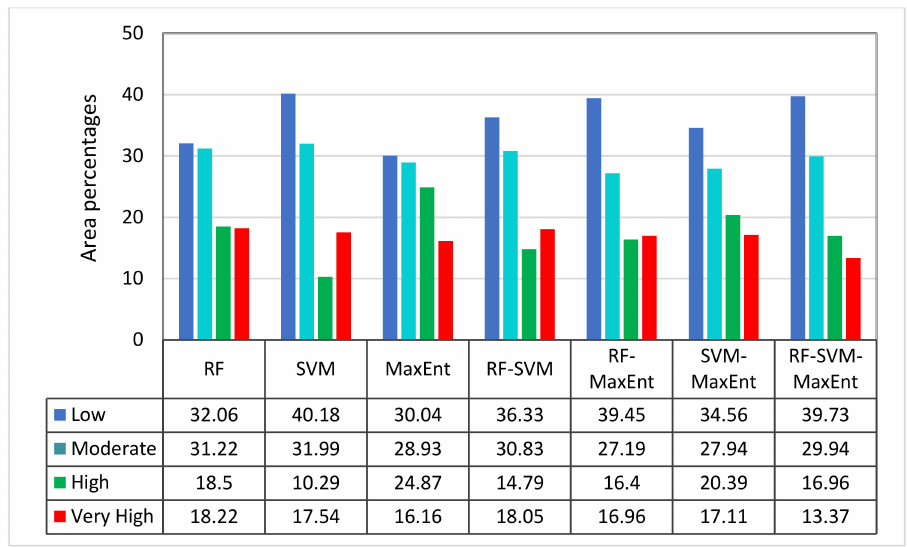
Figure 8. Percentages of di ff erent mineral prospectivity prediction classes.